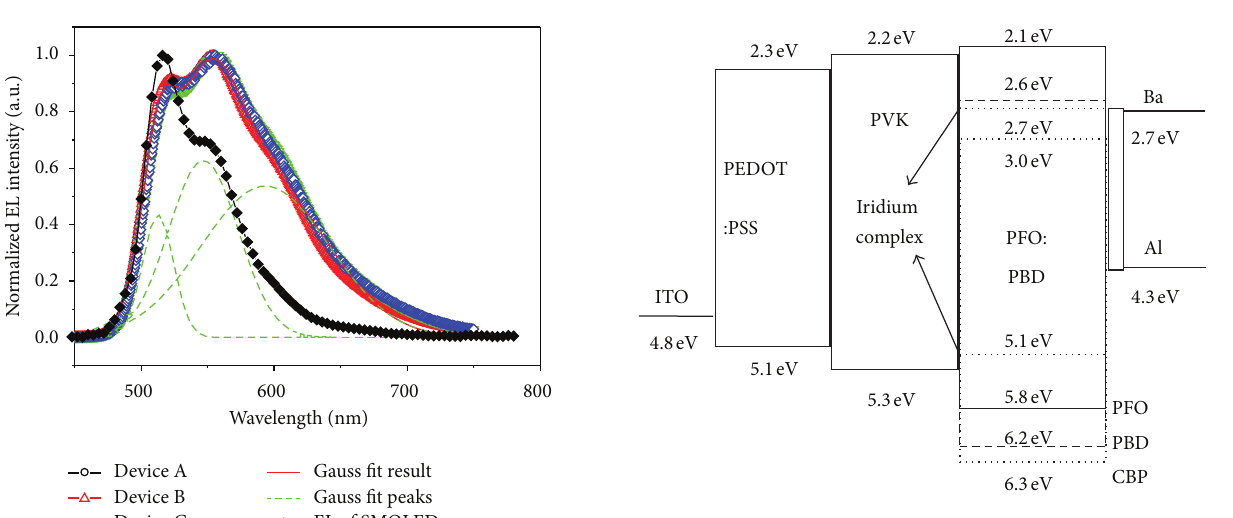
Figure 4: Energy level diagram of polymer light emitting device fabricated in this